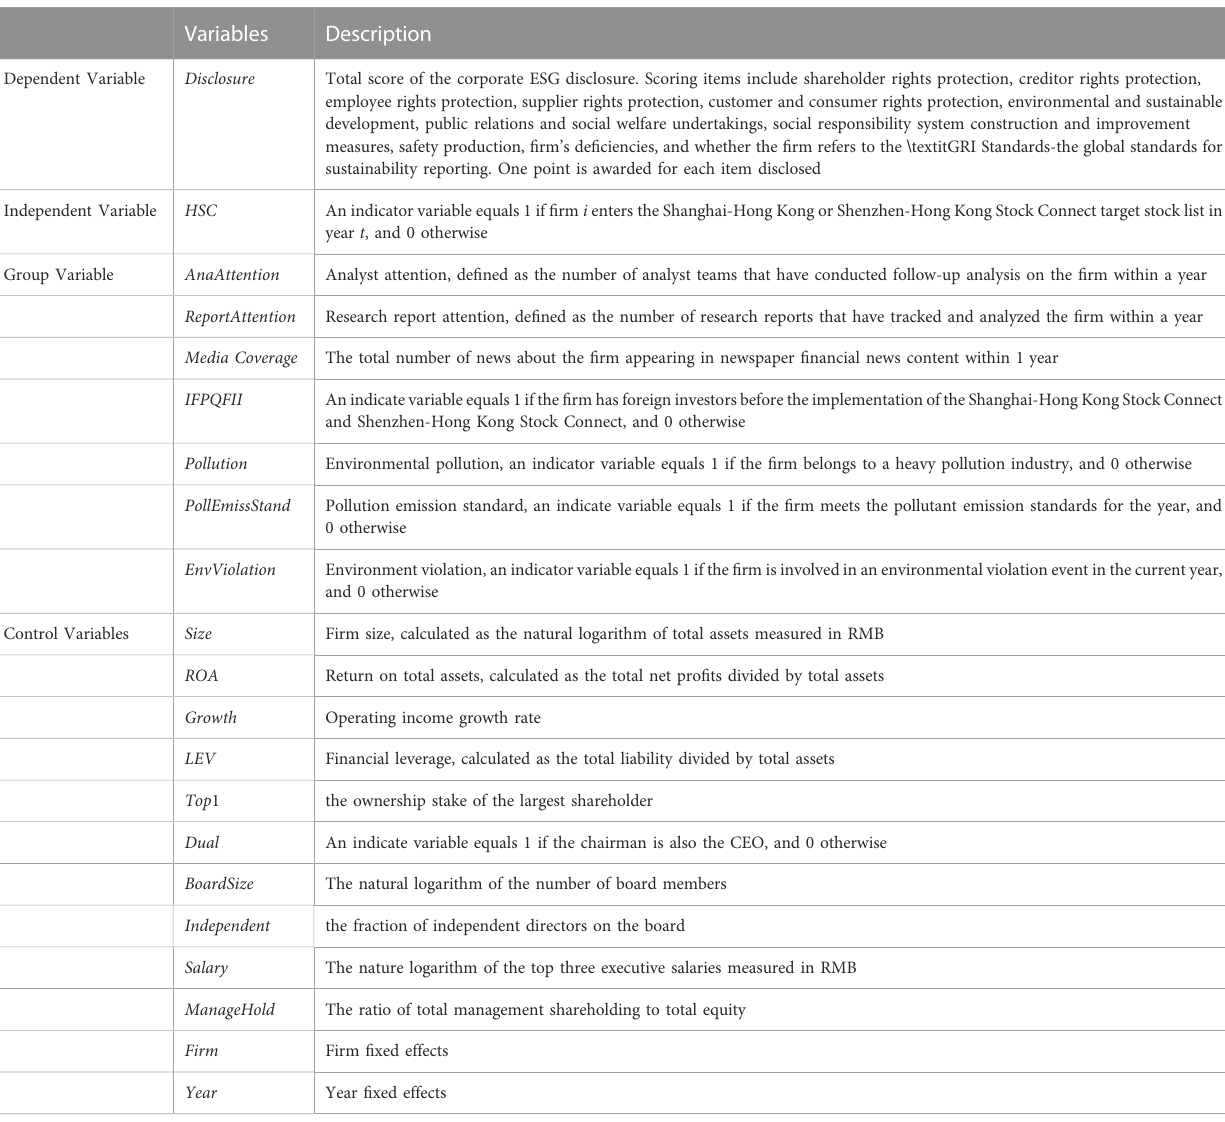
TABLE 1 Variable De fi nitions: This table presents the de fi nition and measure of the key variables used in this paper.